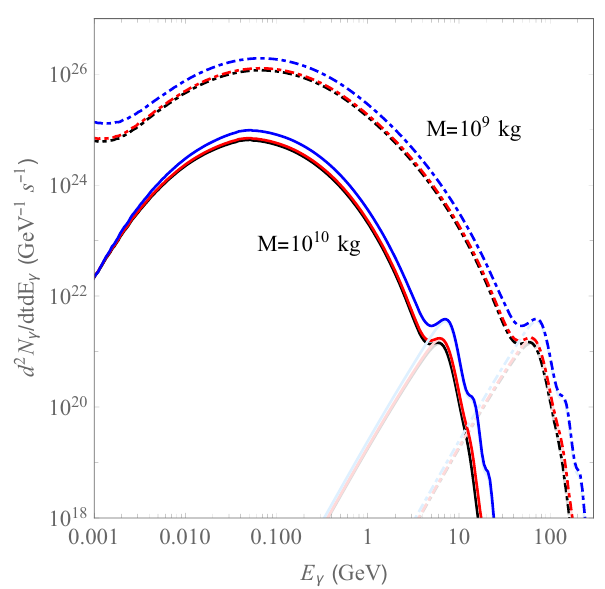
Figure 1 . Primary (light colors) and total (dark colors) photon emission rates for a PBH of 10 10 kg (solid lines) and 10 9 kg (dash-dotted lines), for ˜ a = 0 , 0 . 2 , 0 . 5 (black, red, and blue, respectively). The spectra are obtained using BlackHawk/PYTHIA.